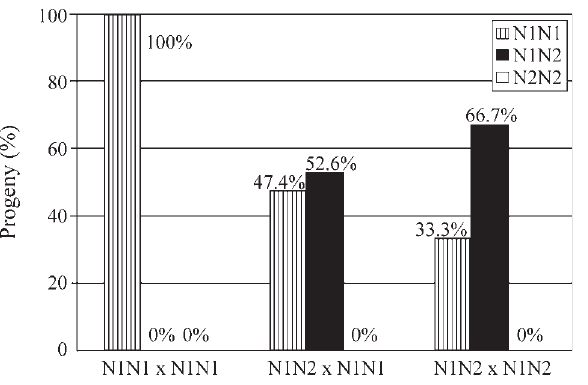
Figure2 -Progenyofartificialcrossesinvolvingdifferentparentalcombi- nations of NOR-bearing chromosomes in rainbow trout ( Oncorhynchus mykiss ).